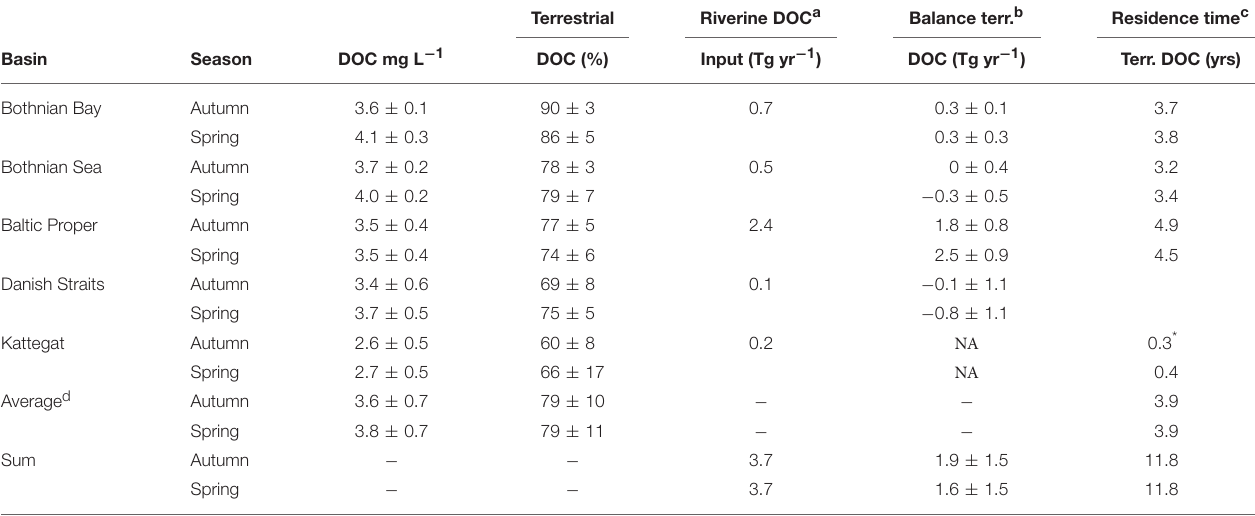
TABLE 3 | Concentrations of DOC and relative abundance of terrestrial DOC (%) in comparison to the riverine DOC input and removal rates of terrestrial DOC (in Tg C per year) for the basins of the Baltic Sea in autumn and spring (means ±